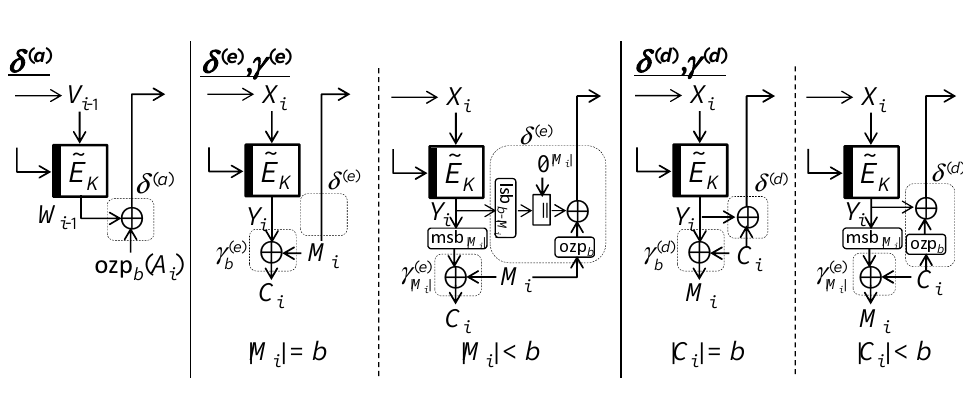
Figure 2: Core procedures of PFB : δ ( a ) , δ ( e ) , δ ( d ) , γ ( e ) , γ ( d ) . A i is an i -th AD block. M i is an i -th plaintext block. C is an i -th ciphertext block. Tweaks are i